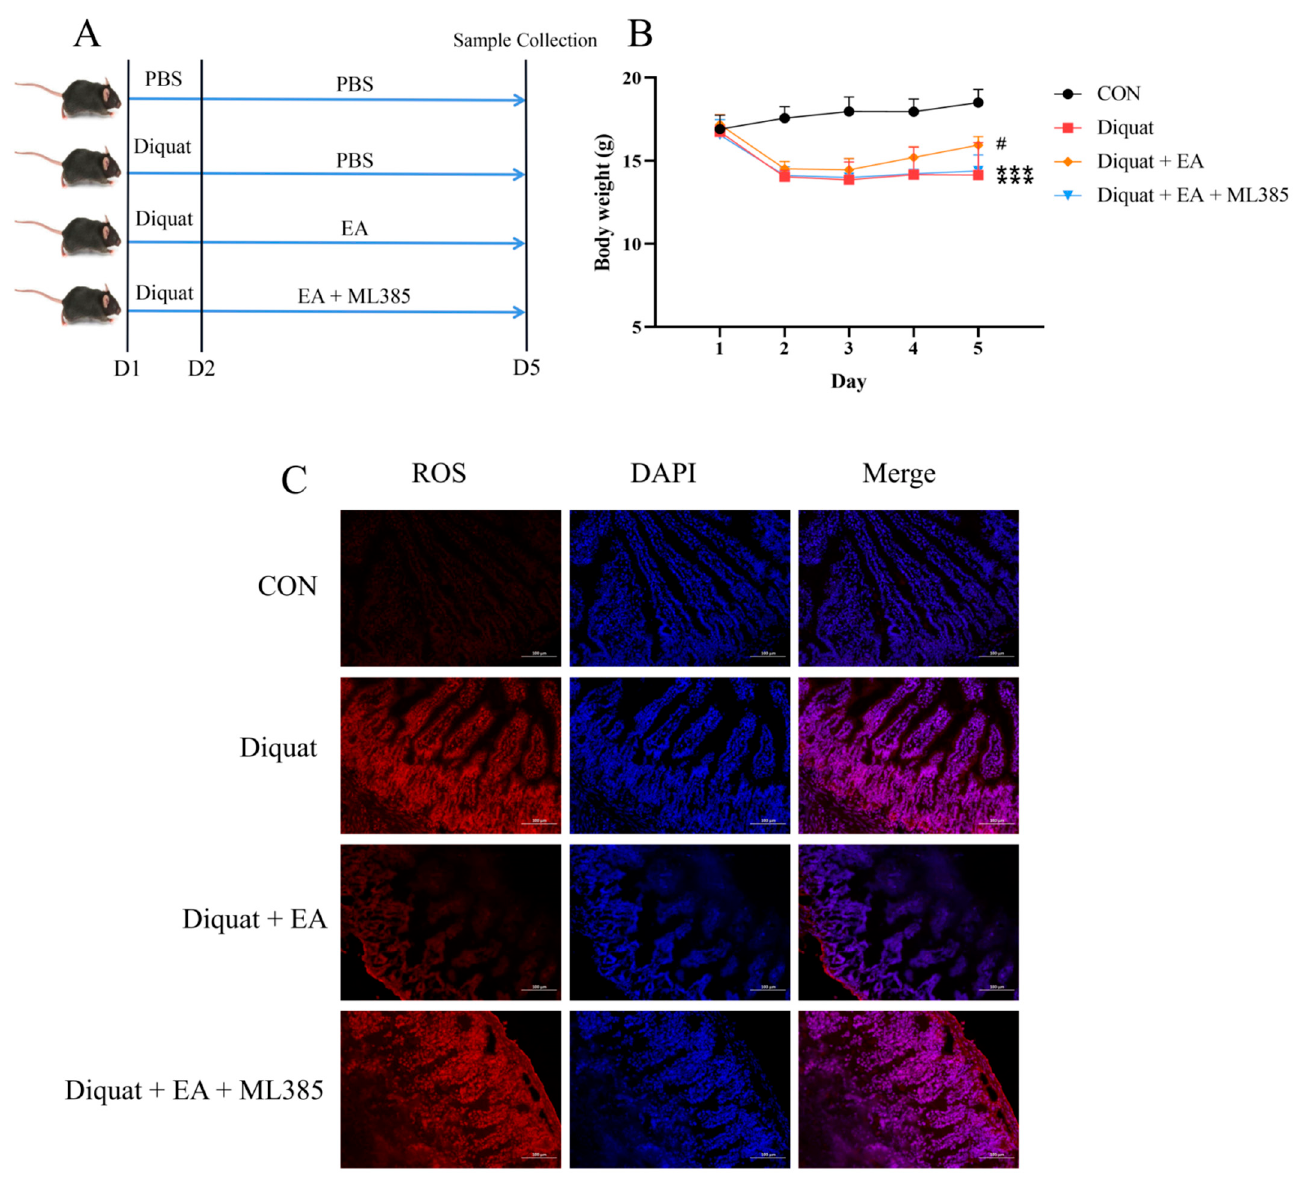
Figure 3. Specific Nrf2 inhibitor (ML385) inhibited the therapeutic effects of ellagic acid on weight loss and increased the ROS level in the jejunum caused by diquat. ( A ) Experimental grouping scheme. ( B ) Body weight curve of mice. ( C ) ROS level in the jejunum. All data were